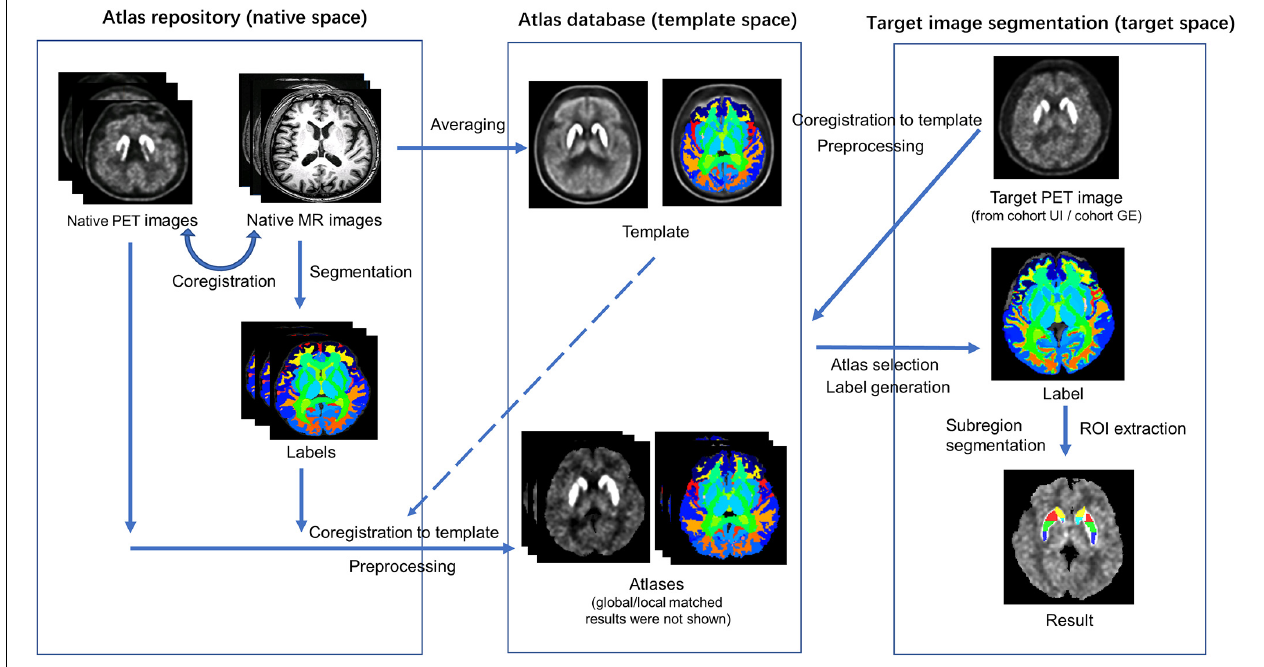
FIGURE 1 | Schematic representation of the procedure for the automatic multi-atlas-based PET image segmentation method.